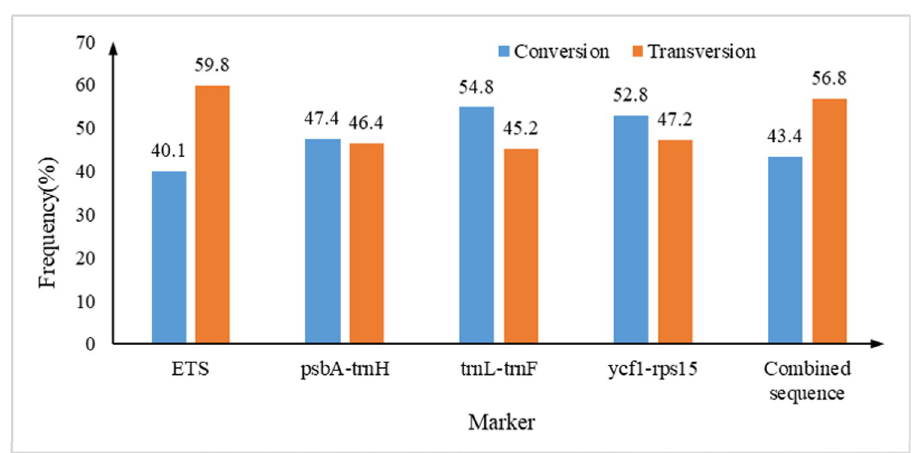
Fig 1. Nucleotide substitution frequencies of the individual and combined intergenic spacers of the cultivated S . miltiorrhiza populations.